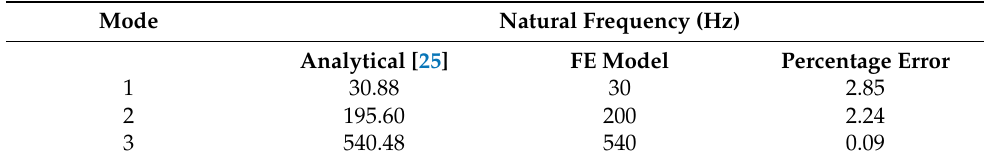
Table 2. Comparison of natural frequencies calculated from FE model and analytical